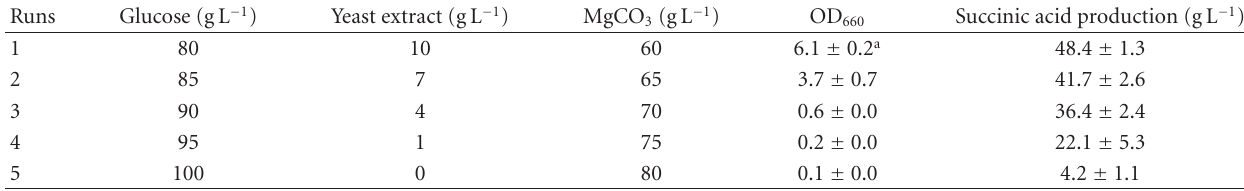
Table 2: Experiment design and results of the steepest ascent path.